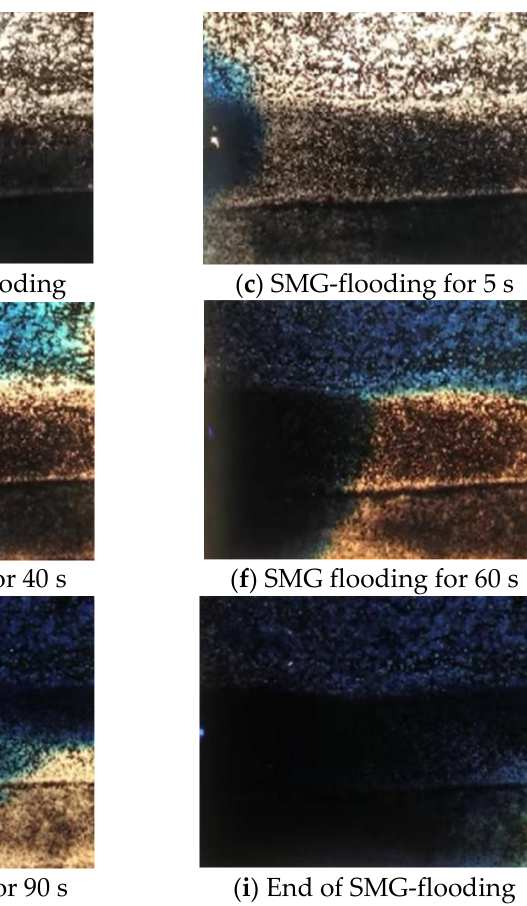
Figure 5. The SMG profile control and oil displacement experiment results for the visual sand in- clusion